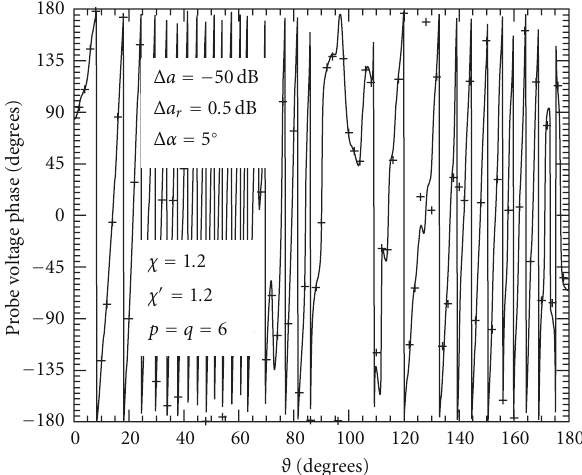
Figure 10: Phase of the output voltage V (cid:2) on the meridian at ϕ = 90 ◦ . Solid line: exact. Crosses: interpolated from error-a ff ected